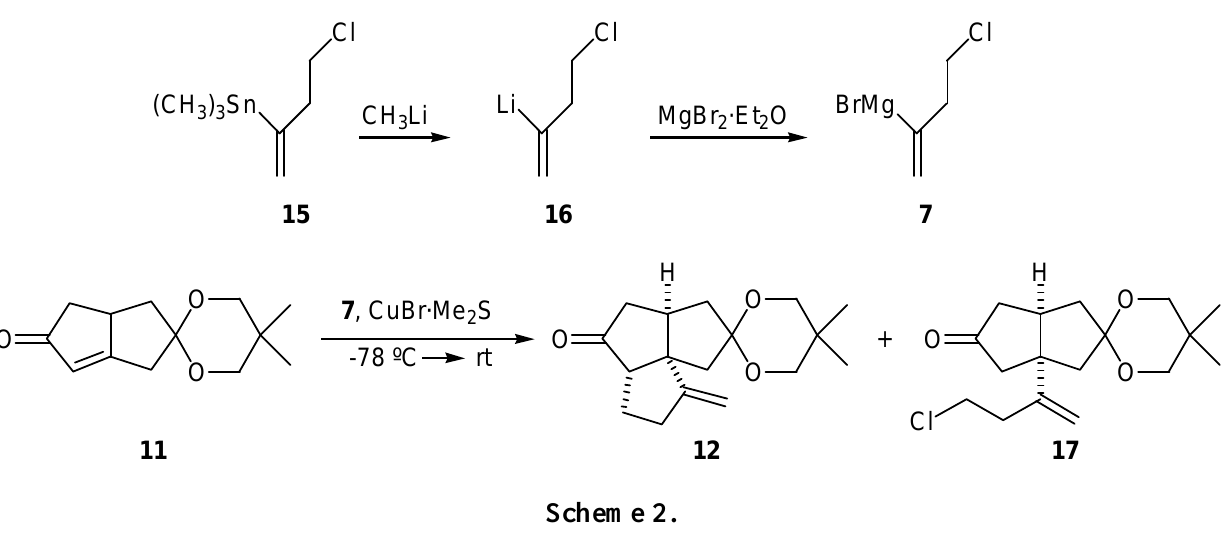
Table 1 . Methylenecyclopentane annulation of the enone ketal ( 11 ).